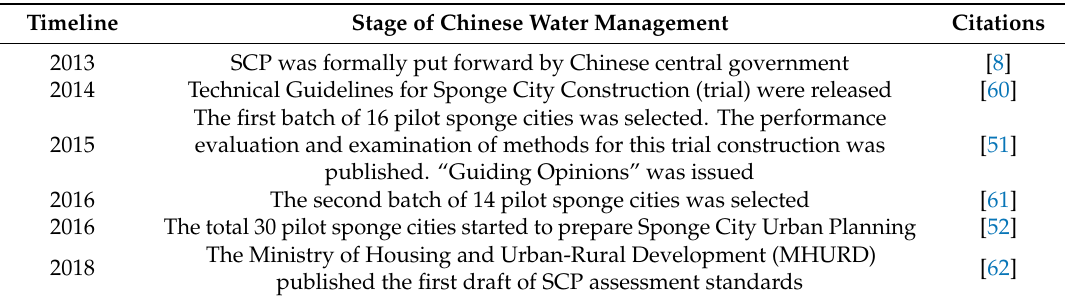
Table 1. The development process of the SCP in